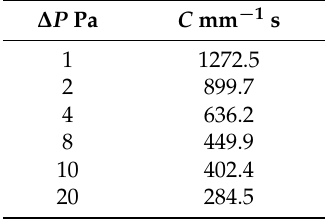
Table 4. C values under certain pressure differences [59].